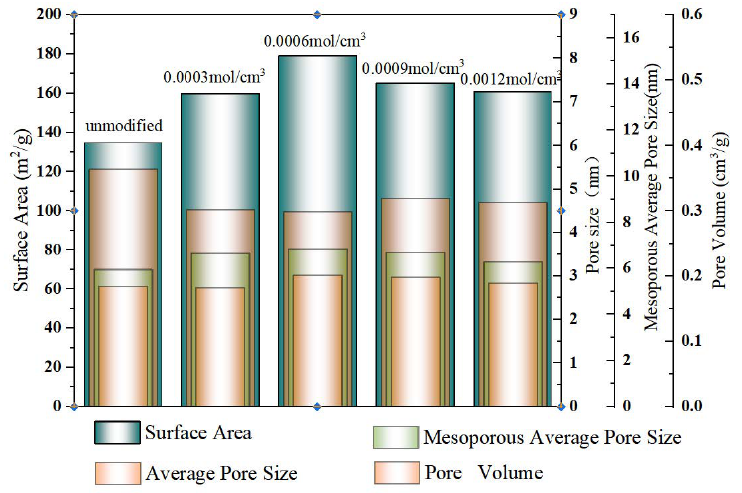
Figure 4. Schematic diagram of specific surface area and pore diameter of oxalic acid-modified activated carbon with different concentrations.